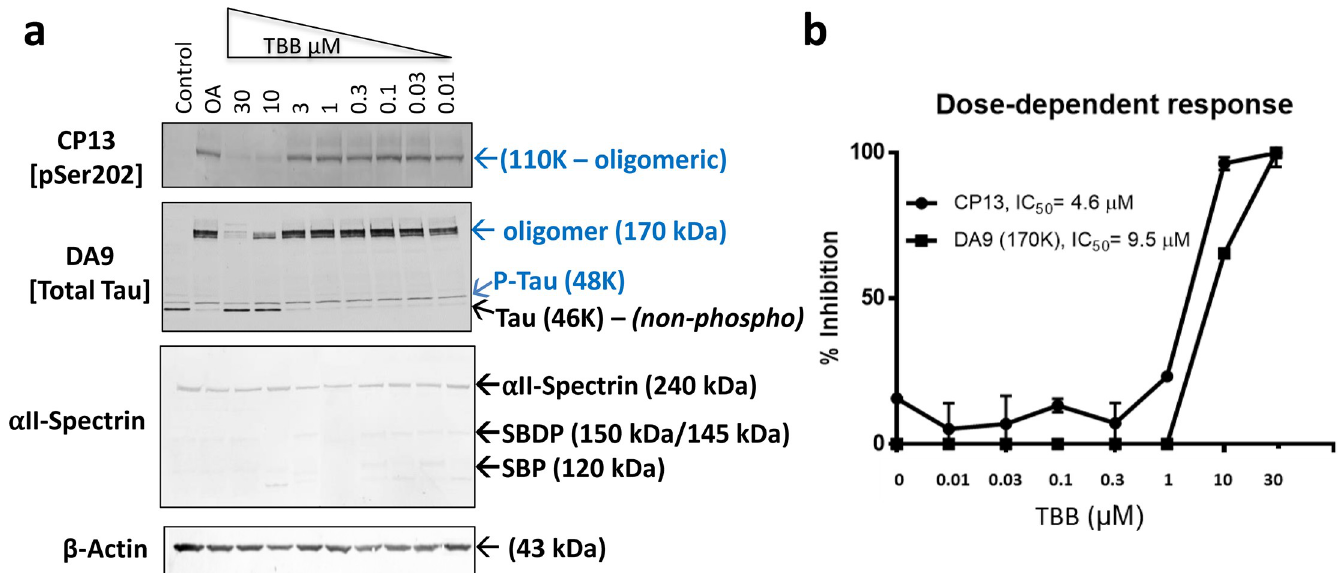
Fig 3. Dose-response of TBB on OA-induced tau hyperphosphorylation and oligomerization in N2a cells. N2a cells were pre-treated with OA for 24h followed by treatment with different concentrations of TBB for 6h, as indicated in the Figure. (a) Immunoblots of cell extracted proteins using phospho-tau antibodies, including CP13 (pSer202), and total tau DA9 (a.a. 102–140). Blue arrows represent monomeric and oligomeric p-tau (48 kDa, 110 kDa, and 170 kDa). α II-Spectrin antibody used to monitor SBDPs with the increasing concentrations of TBB. The β -actin antibody was used as a loading control. All conditions included SNJ-1945 (calpain inhibitor) and Z-DCB (caspase inhibitor). (b) TBB dose-response treatment line chart. TBB concentration (in micromolar) is shown on the X-axis, and the inhibition percentage is presented on the Y-axis. The control sample values were designated as the standard response. The X-axis concentration values are logarithm-transformed to fit a straight line. The half-maximal inhibitory concentration (IC 50 ) was used to measure the effectiveness of TBB in inhibiting OA-induced tau hyperphosphorylation and oligomerization. GraphPad Prism was used to calculate the IC 50 (for DA9 and CP13 antibodies) and are presented on the figure. The statistical analysis was performed with one-way ANOVA, followed by Bonferroni’s post-hoc test. � p < 0.05, �� p < 0.01, ��� p < 0.001. Data are presented as ± SEM for n = 3.